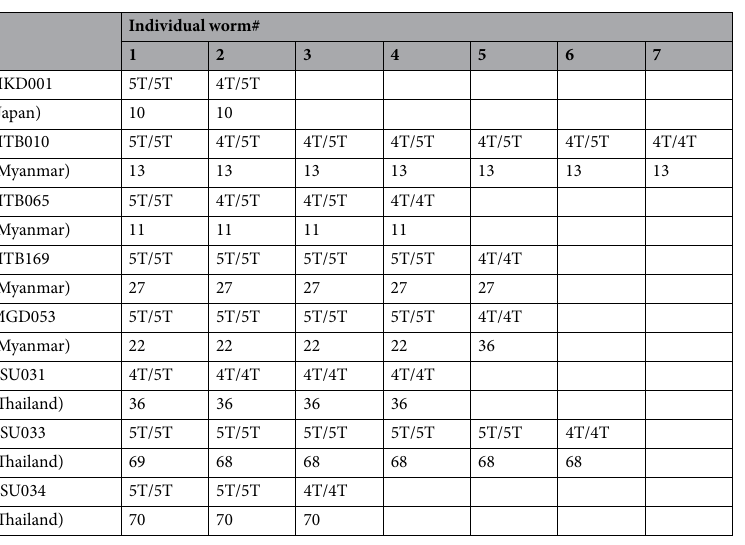
Table 3. 18S rDNA hyper-variable region I (HVR-I) genotypes of individual Strongyloides worms from selected human hosts. Eight human hosts were selected based on the presence of at least one isolated Strongyloides worm with a rare HVR-I genotype (4T/4T or 4T/5T). Two to seven worms/host were successfully genotyped. Each box represents an individual worm. The upper row shows the HVR-I genotype, and the lower row contains the Cox1 haplotype